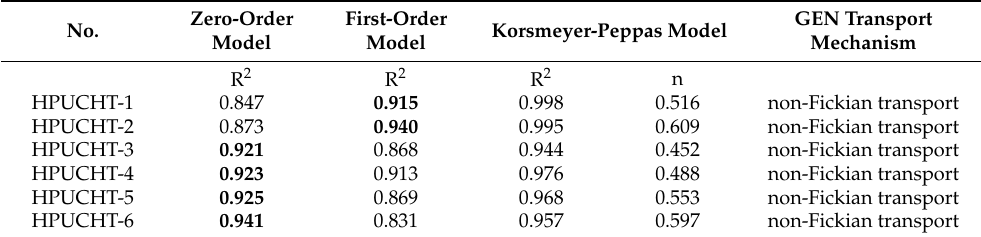
Table 3. Analysis data of GEN release from the obtained